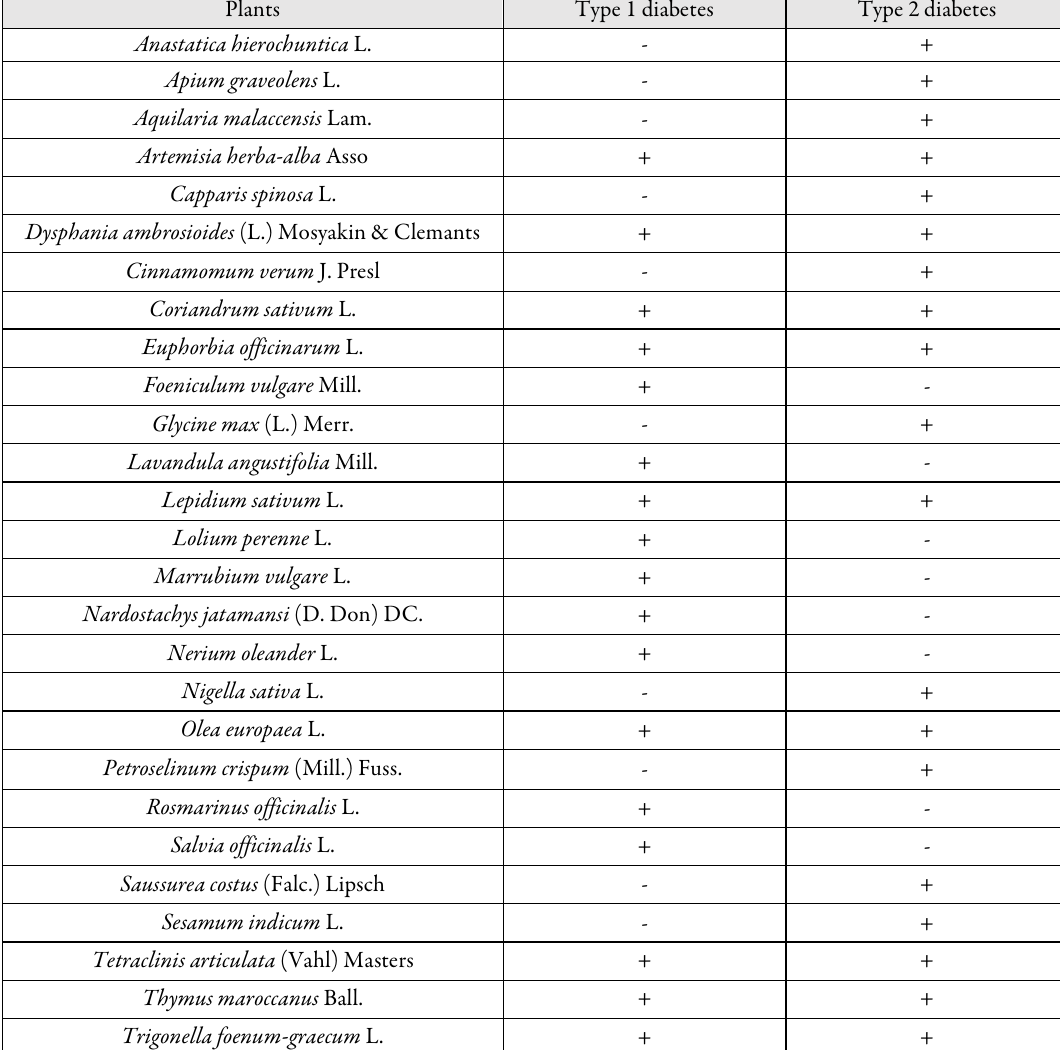
Table 5. Plants used by patients according to their type 1 or type 2 diabetes diseases Plants Type 1 diabetes Type 2